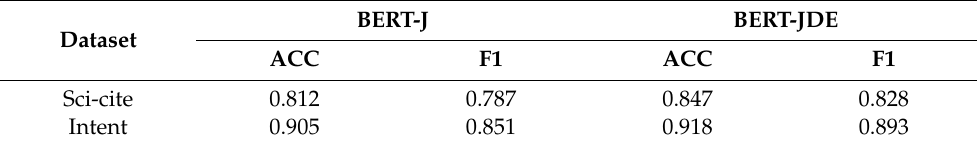
Table 4. Comparison among data-enhancement